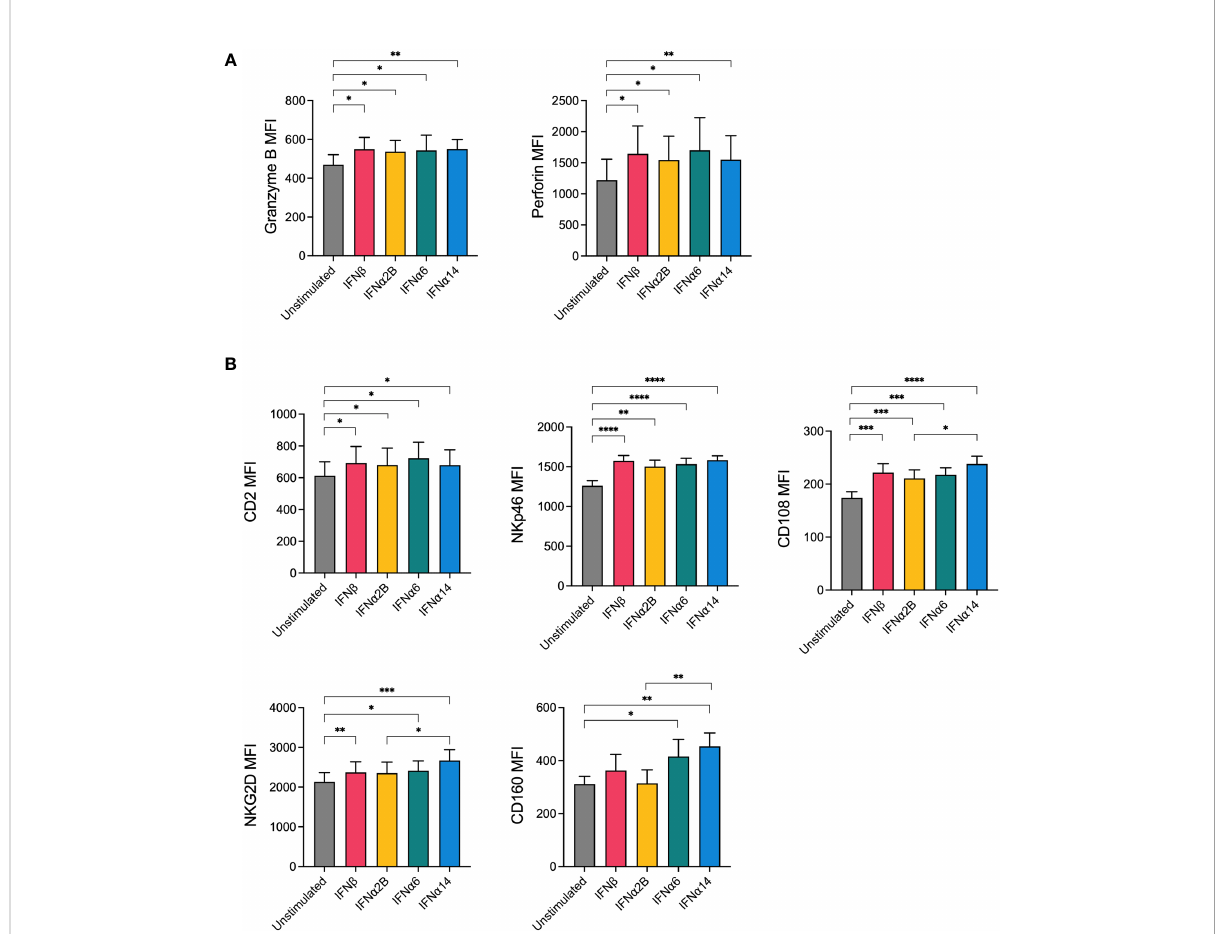
FIGURE 2 NK cells display increased expression of cytotoxic effector molecules and activation markers following IFN-I activation PBMCs were either left unstimulated or were stimulated with 100 IU mL -1 of IFN b , IFN a 2B, IFN a 6 or IFN a 14 overnight. Following overnight activation, CD56 + CD3 neg NK cells were assessed for the expression of granzyme B and perforin or for the expression of fi ve activation markers (CD2, NKp46, CD108, NKG2D, CD160). (A) Summary plots show the mean ± SEM granzyme B or perforin MFI in unstimulated and IFN-I stimulated NK cells. (B) Summary plots show the mean ± SEM MFI of the indicated activation markers in unstimulated and IFN-I stimulated NK cells. n = 8-13 healthy donors. Data were compared using paired Student ’ s t tests. * p < 0.05, ** p < 0.01, *** p < 0.001, **** p <